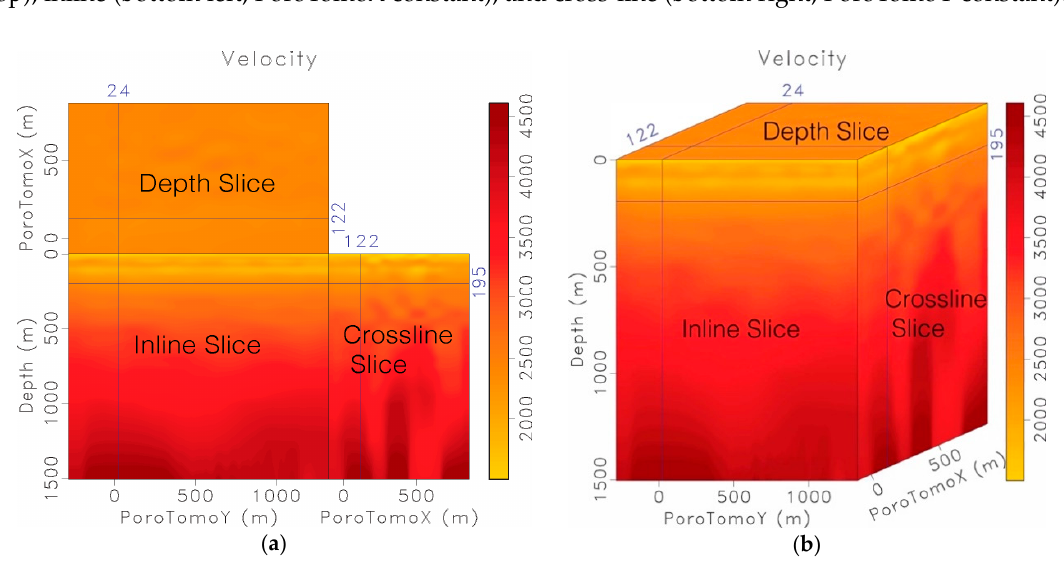
Figure 4. P-Wave Velocity (Vp) model from sweep interferometry [28] with the black lines approximately indicating the location of Well 56-1 at PoroTomoY = 119, PoroTomoX = 24, and depth is 195 m. ( a ) the flattened cube view with the top the depth slice at 195 m below reference elevation of 1277 m above WGS84 ellipsoid, the lower left the PoroTomoX = 122 slice (inline), the lower right the PoroTomoY = 24 slice (cross-line). ( b ) is the 3D perspective.